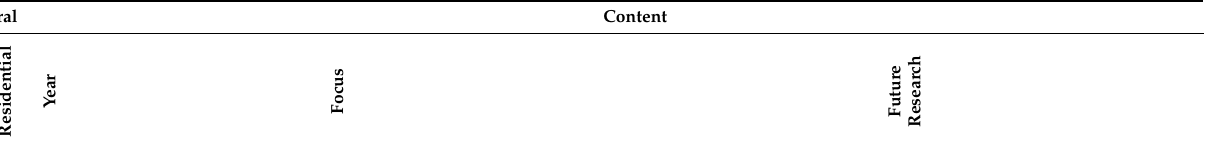
Table 1. Concept matrix of previous reviews for residential and industrial energy management systems.